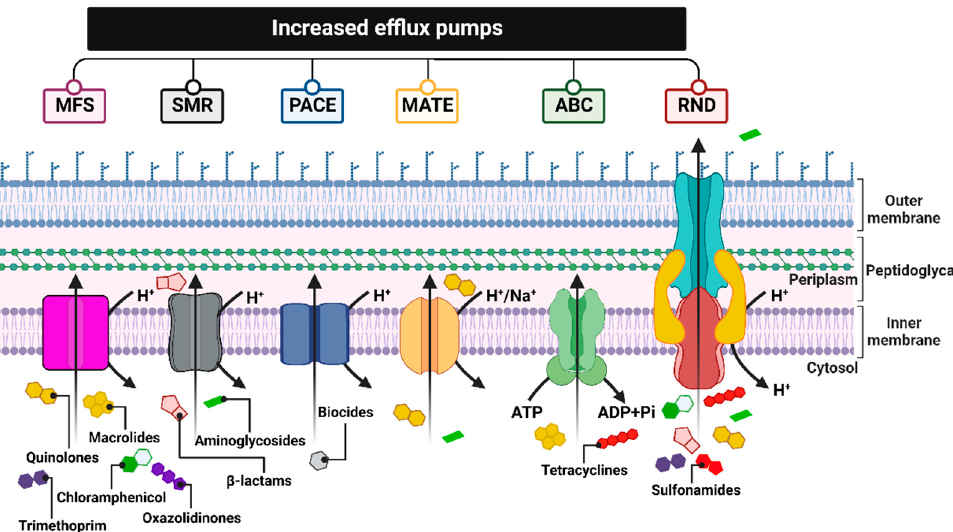
Figure 9. Summary of the six major families of efflux transporters: MFS (a superfamily of the main facilitator), SMR (the small multidrug resistance family), PACE (proteobacterial antimicrobial compound efflux), MATE (multidrug and toxic compound extrusion family), ABC (ATP binding cassette superfamily) and RND (resistance nodulation division family). Figure created with Biorender.com.